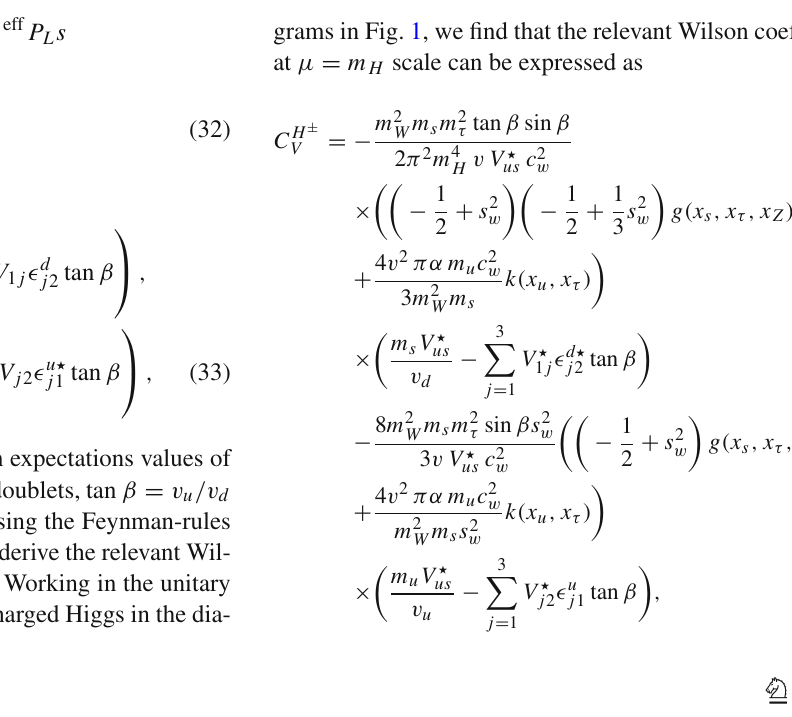
Fig. 1 Diagrams contributing to the effective Hamiltonian, H ef f , in Eq. (3) up to one loop-level due to charged Higgs mediation. In the figures, V can be Z boson or photon or both of them depending on the fermions A and B . In the case that A and B are τ and ν τ , the other